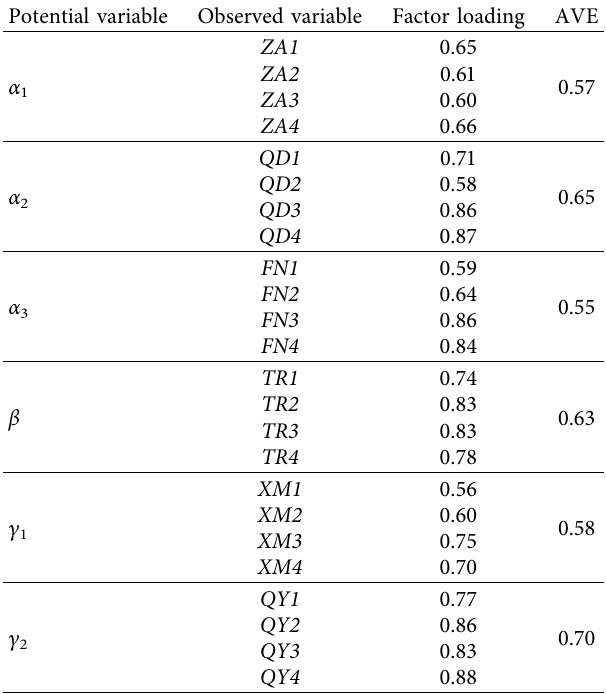
Table 3: Test results of the model.